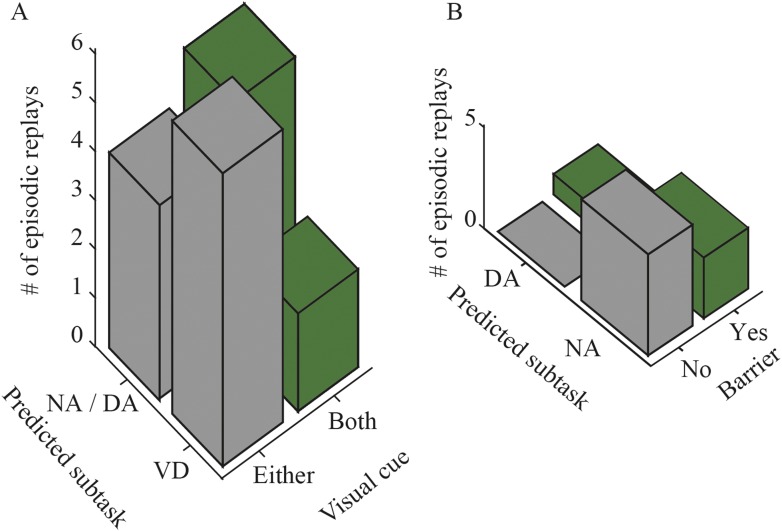
The relationship between predicted subtask and sensory cue.(A) The number of episodic-junction replays with matches between the predicted subtask and the configuration of visual cues, across all rats. (B) The number of episodic-center replays with matches between the predicted memory-guided subtask and the presence of a barrier at the center of the maze, across all rats.